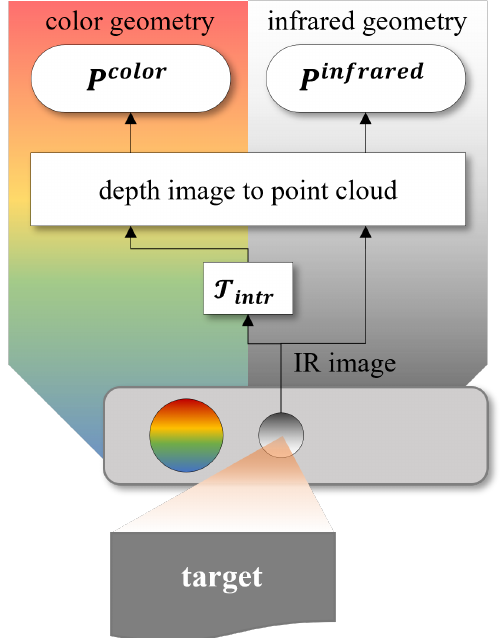
Figure 2. Schematic representation of the point cloud realization with color and infrared geometries, using the Azure Kinect